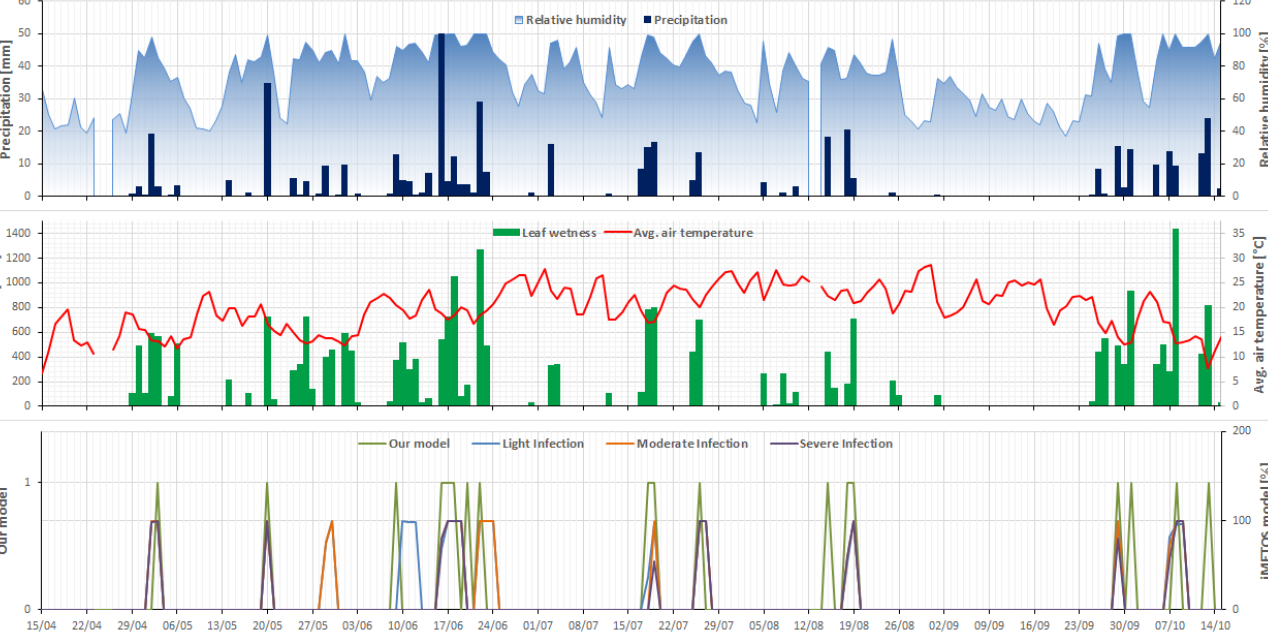
Figure 14. Primary infection alarms for the location ’Vršaˇcki